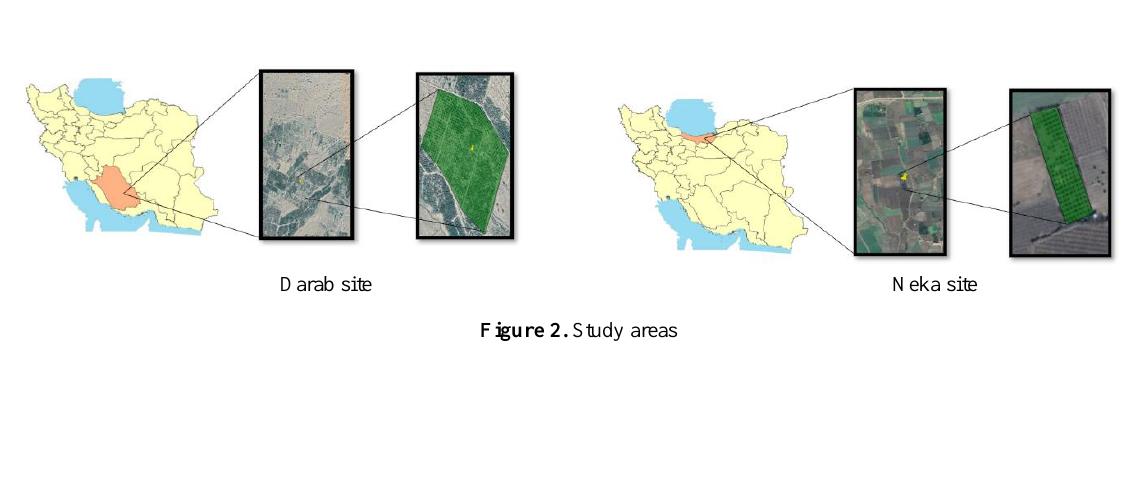
Figure 1. Workflow of the proposed method